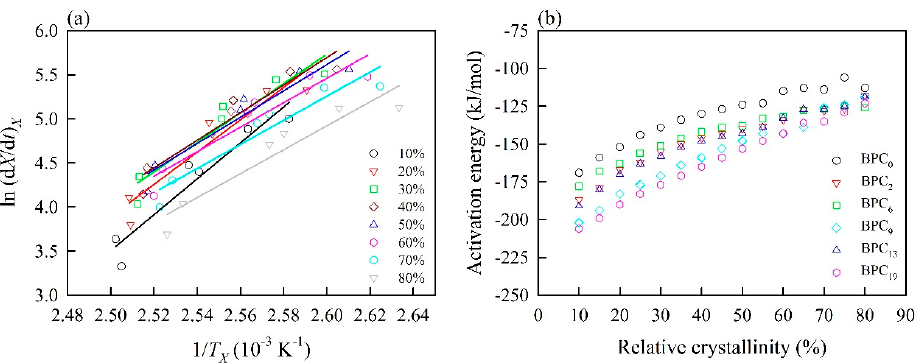
Figure 4. Nonisothermal crystallization kinetics of PP with unmodified and acetylated bamboo fibers using the Friedman method. ( a ) Friedman plots of ln (d X / d t ) X versus 1 / T X for PP with unmodified bamboo fibers; ( b ) dependence of the effective activation energy on the relative crystallinities.